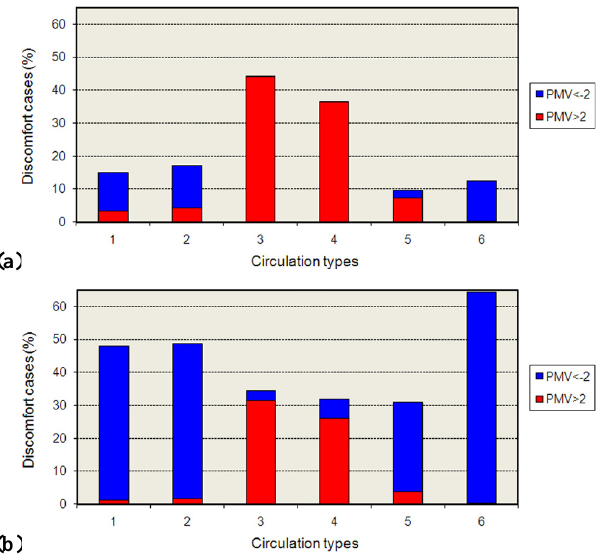
Fig. 8. Percentage of discomfort cases in Athens at 14:00 for the 6 circulation types defined by Kassomenos et al. (2003), for (a) calm and (b) light wind conditions.